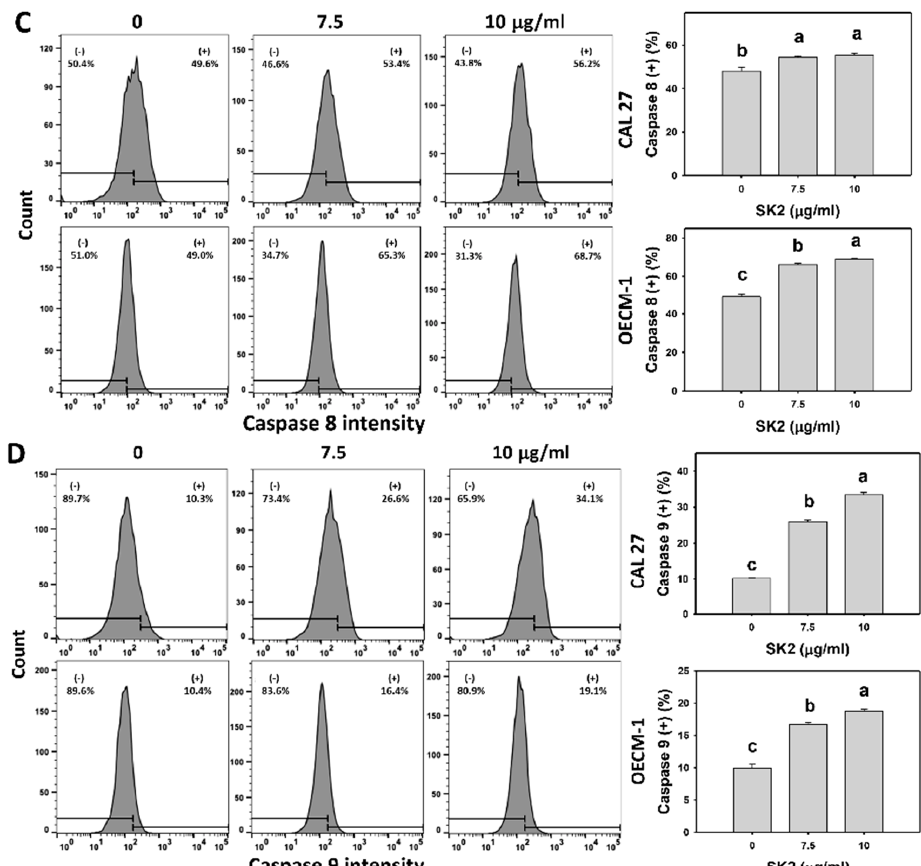
Figure 4. SK2 triggers caspase signaling in oral cancer cells. ( A – D ) Pancaspase and Cas 3, 8, and 9 detections, and statistics are provided. Cells were exposed to SK2 (0 (0.1% DMSO), 7.5, and 10 µg/mL) for 24 h. (+) shown in each panel represents pancaspase and Cas 3, 8, and 9 (+). Data (means ± SDs; n = 3) without overlapping characters differed significantly ( p < 0.05). For CAL 27 and OECM- 1 cells ( D ), for SK2 at 0, 7.5, and 10 µg/mL, “c, b, and a” indicate significant differences because the data did not overlap. For an example of CAL 27 cells ( B , C ), for SK2 at 7.5 and 10 µg/mL, the same letter “a” indicates non-significant differences because the data overlapped.